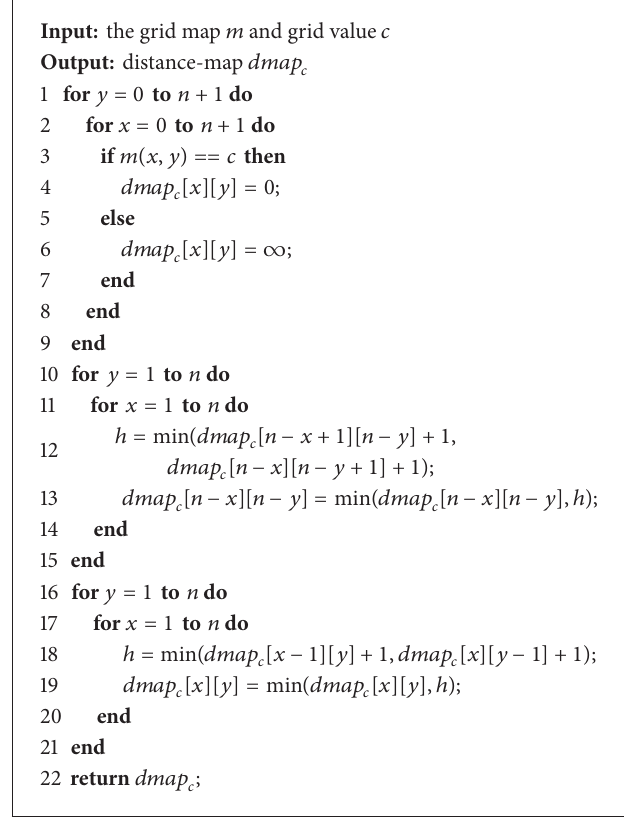
Algorithm 1: Calculation process of distance-map 𝑑𝑚𝑎𝑝 𝑐 in grid map.